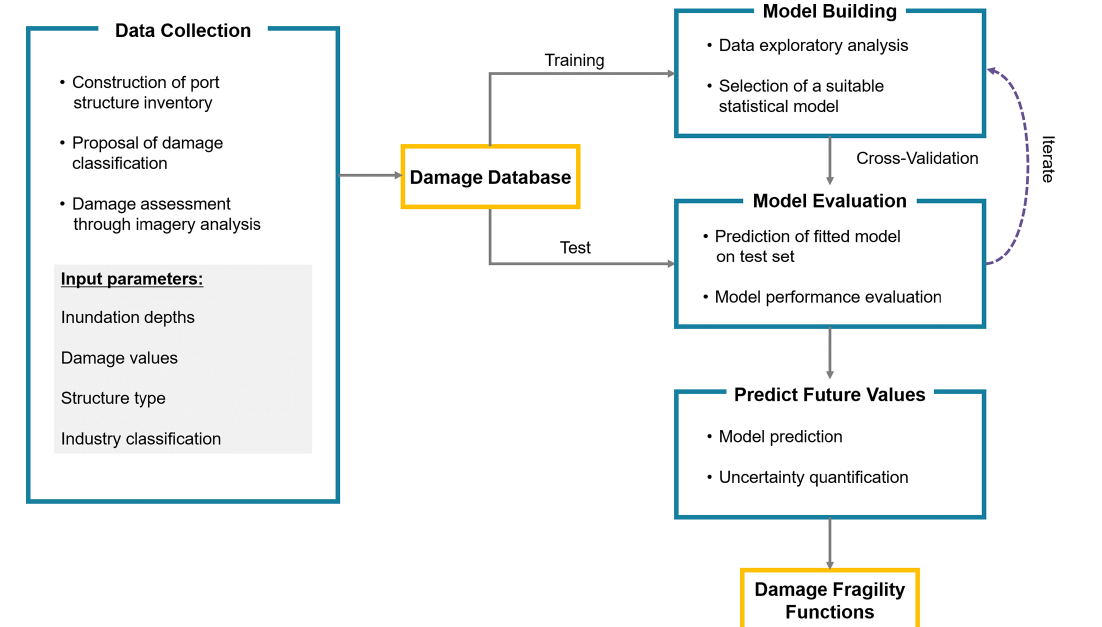
Figure 2. The framework of this study follows the approach of a machine-learning workflow. A damage database for port structures is constructed through data collection and processing. The consolidated data are then randomly split into training and test sets for model building and evaluation. This process is usually iterated until a satisfactory model is selected for the development of fragility functions. This is usually the case where there is more than one model or parameter to choose from, whereas in our case only inundation depth was considered as an explanatory